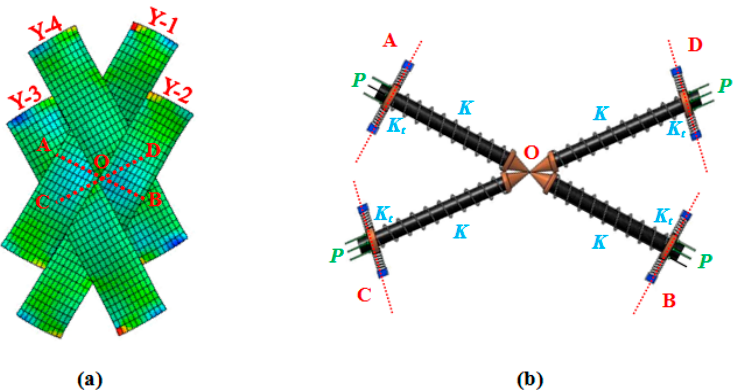
Figure 6. ( a ) Representative PWCP element in post-locking stage; ( b ) four-link equivalent structure mimicking the behavior of a representative PWCP element in post-locking stage.